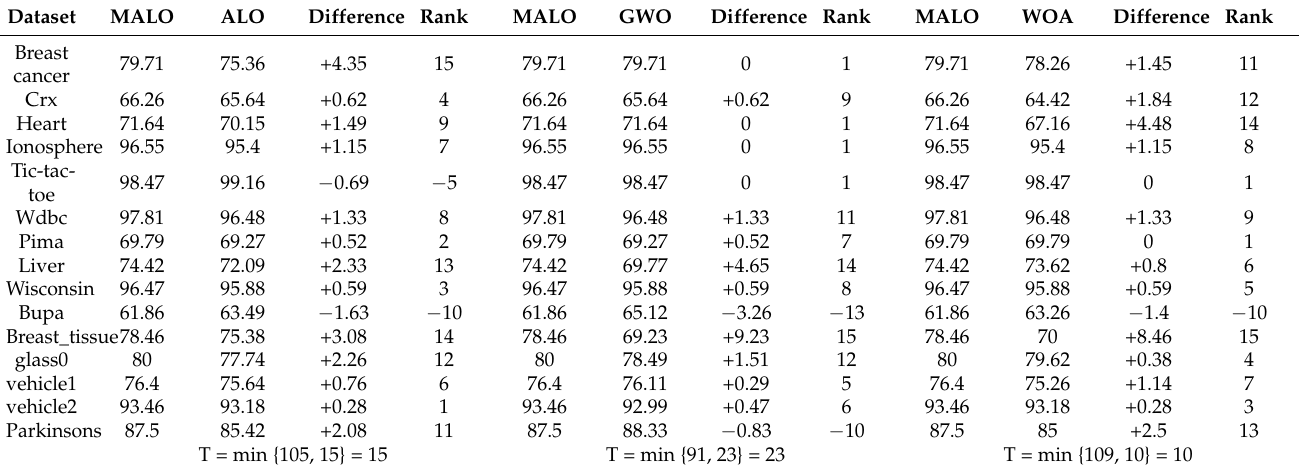
The accuracy comparison: Table 11 shows the significance test results of average accuracy for MALO vs. ALO, MALO vs. GWO, and MALO vs. WOA, using the SVM classifier. In the case of MALO vs. ALO, MALO is better (+ve difference) than ALO for 13 datasets, while ALO is better ( − ve difference) than MALO for two datasets.